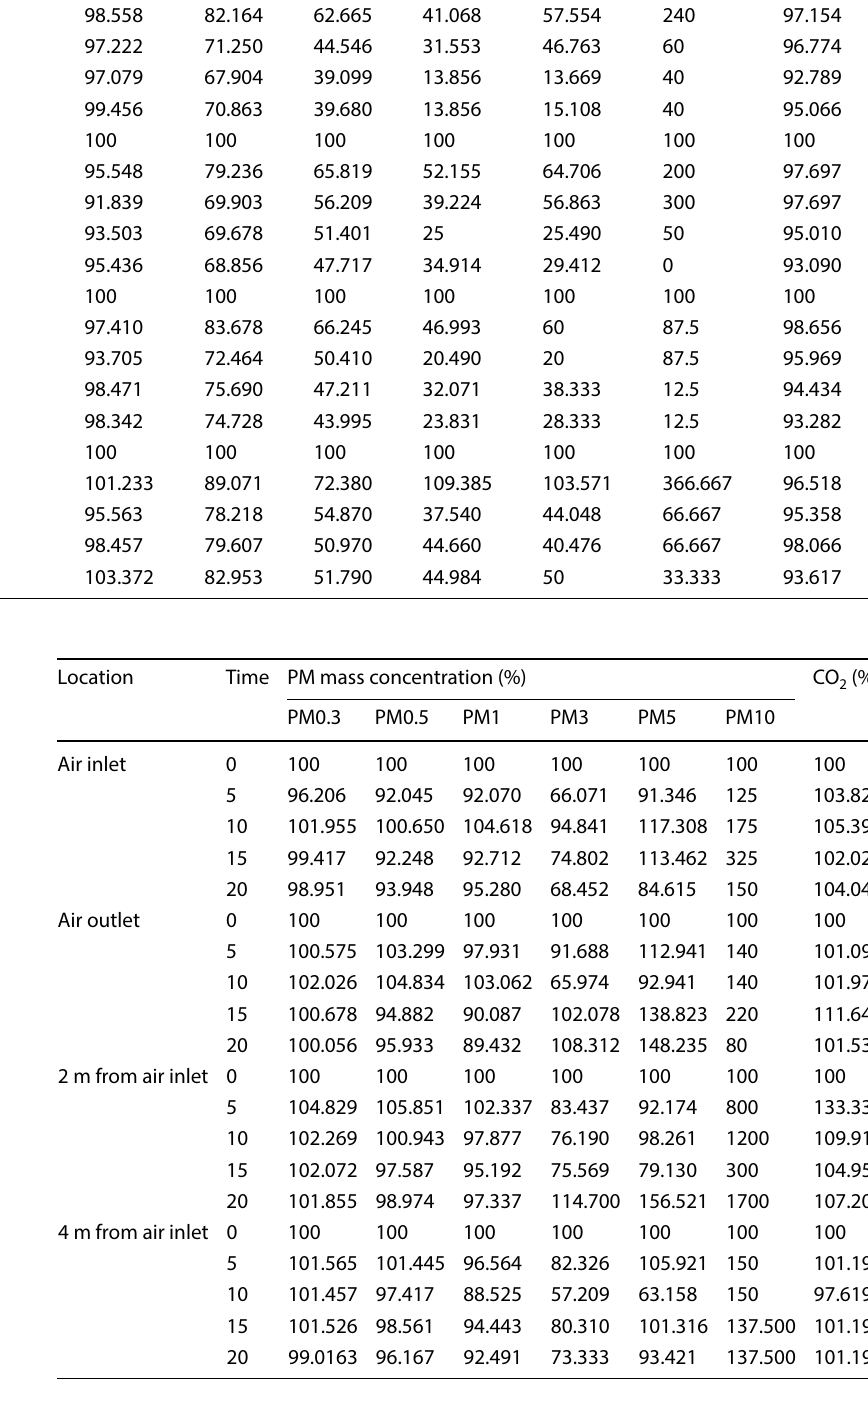
Table 1 The percentage differences in PM concentration, CO Location